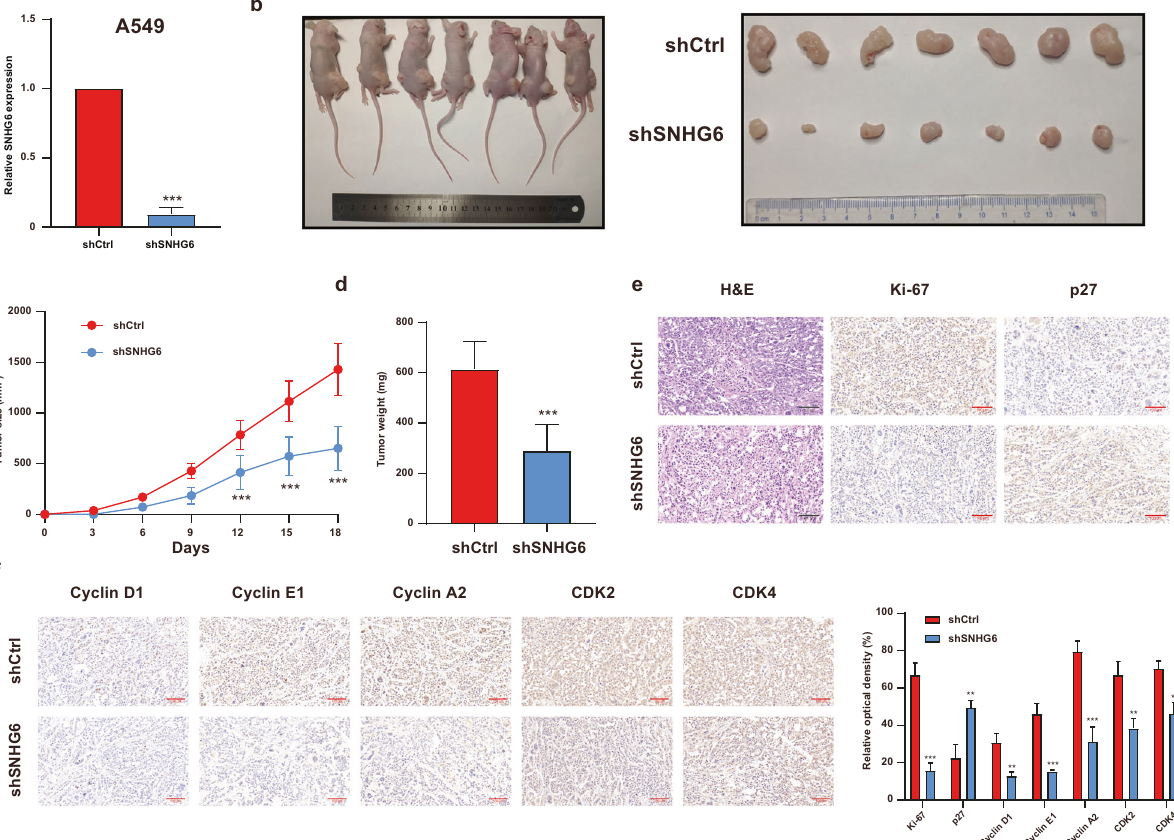
Fig. 6 SNHG6 knockdown restrained tumor growth in vivo. a shSNHG6 downregulated the expression of SNHG6 in A549 cells; b The stably transfected A549 cells were subcutaneously injected into the back of nude mice, right for the shCtrl group and left for the shSNHG6 severally; c The volumes of tumors were measured every 3 days and the growth curves of the shCtrl group and shSNHG6 group were exhibited; d The weights of dissected tumors were detected; e The tumor sections were undergone H&E, Ki-67, and p27 staining; f The IHC staining of cyclin D1, cyclin E1, cyclin A2, CDK2, and CDK4 were conducted. Data were analyzed by unpaired student ’ s t -test. *** P < 0.001, ** P < 0.01. Variables were presented as the mean ±